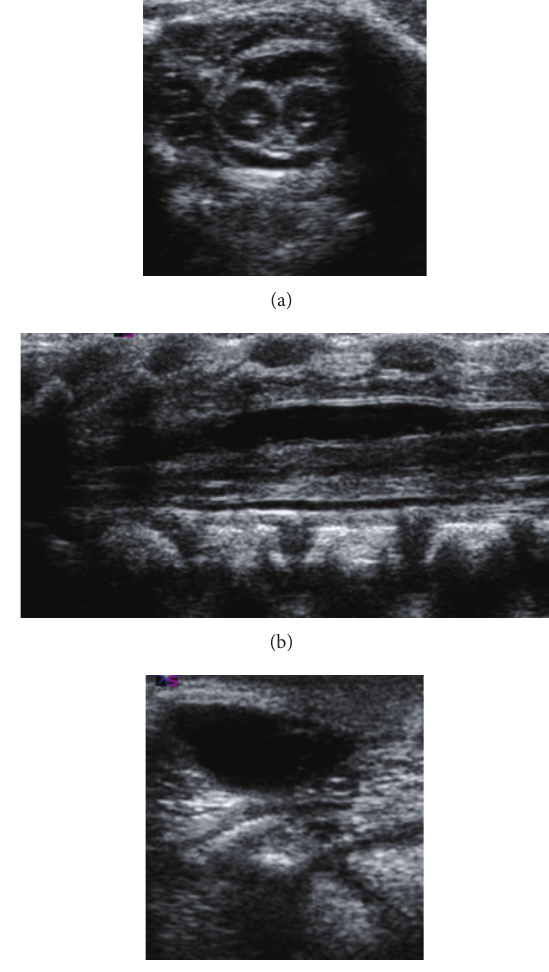
Figure 5: US for the spines: (a) TS scan for cord at upper lumbar region demonstrating the splitted cord (diastematomyelia), (b) LS scan at lumbar region showing the dural ectasia and the cord splitting in long axis, (c) demonstrating the meningocele at lower sacral